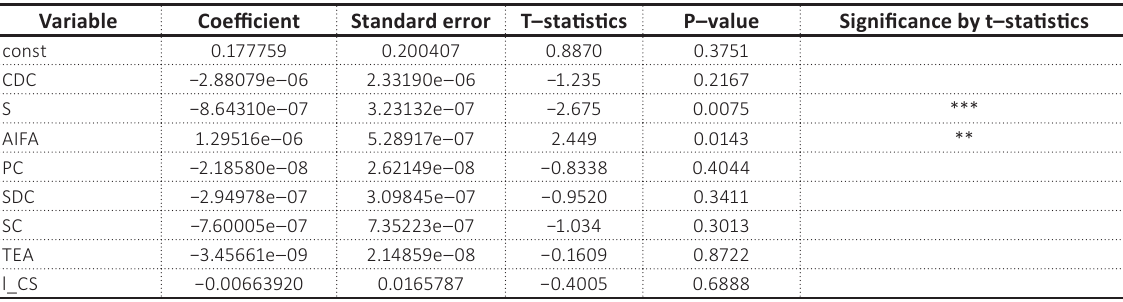
Table 5. Model 2 (NPM). FEM (robust standard errors), using the observations 1-80